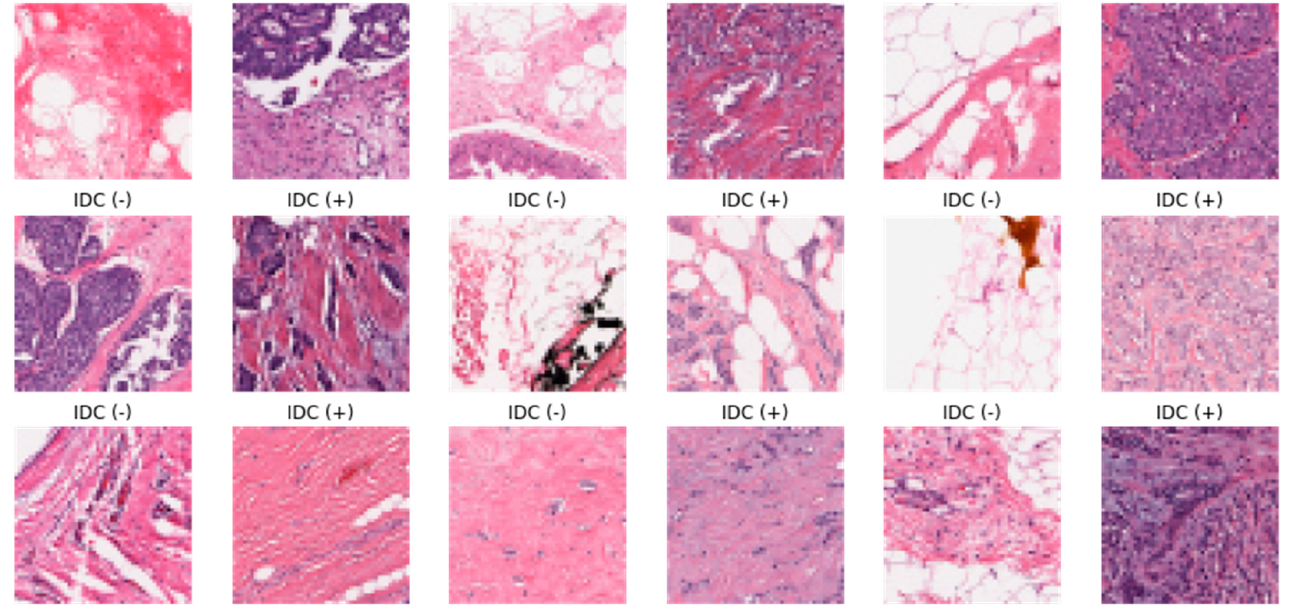
Figure 12. Correctly classified images by fine-tuned 3D U-Net classifier.